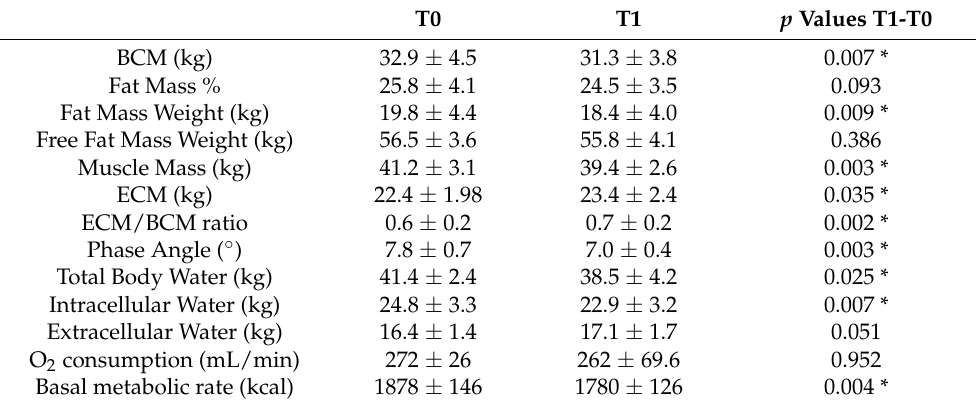
Table 2. Bioelectrical impedance analysis of female volleyball athletes (n = 10) before COVID-19 infection (T0) and at the return-to-training day